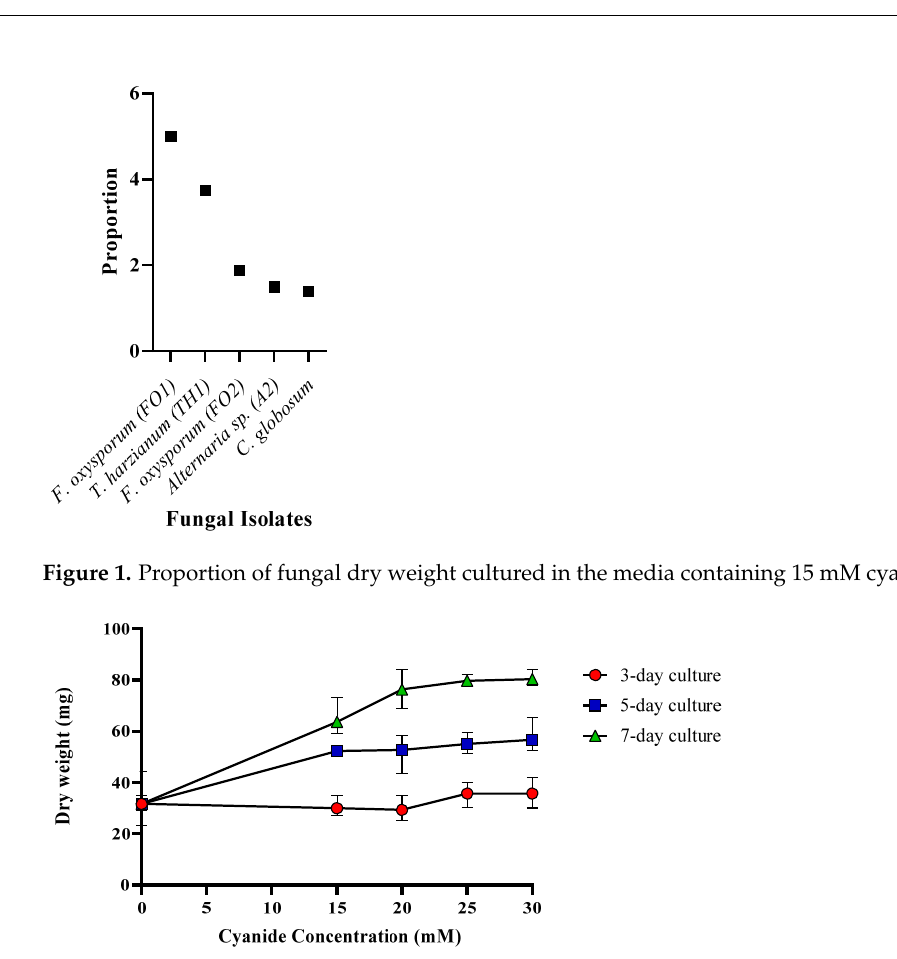
Figure 2. T. harzianum dry weight in cyanide-containing media (15, 20, 25, and 30 mM cyanide).